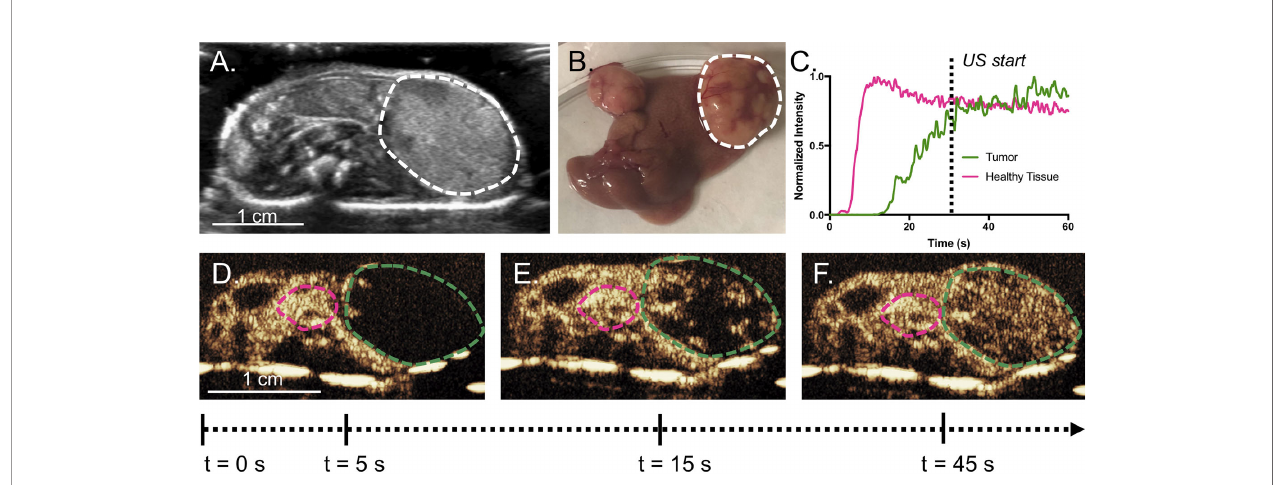
FIGURE 3 | (A) Representative cross-sectional B-mode image of a mouse with a tumor (bounded by dashed line) taken with the L12-5. Tumors can be easily delineated by gross anatomical morphology, as in (B) . Example TICs from the tumor and the normal parenchyma are shown in (C) with (D – F) showing the original CEUS images and ROIs, where the green line is the tumor and the pink line is healthy tissue. Intensity was normalized to peak intensity within each respective ROI, in order to highlight differences in time parameters. In this example, the tumor does not reach its peak intensity until after the 60 s. The wash-in of microbubbles is slower in the tumor than the surrounding tissue. USCTx was chosen to start at 30 s, when the tumor had suf fi cient microbubble